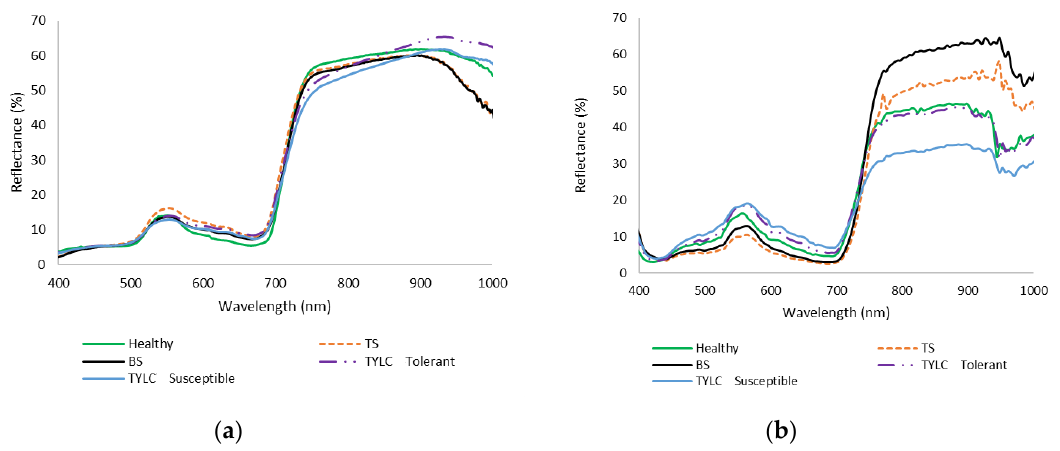
Figure 4. The spectral reflectance signatures of TYLC (on susceptible and tolerant tomato varieties), bacterial spot (BS), and target spot (TS) infected tomato plants: ( a ) in laboratory conditions and ( b ) field conditions